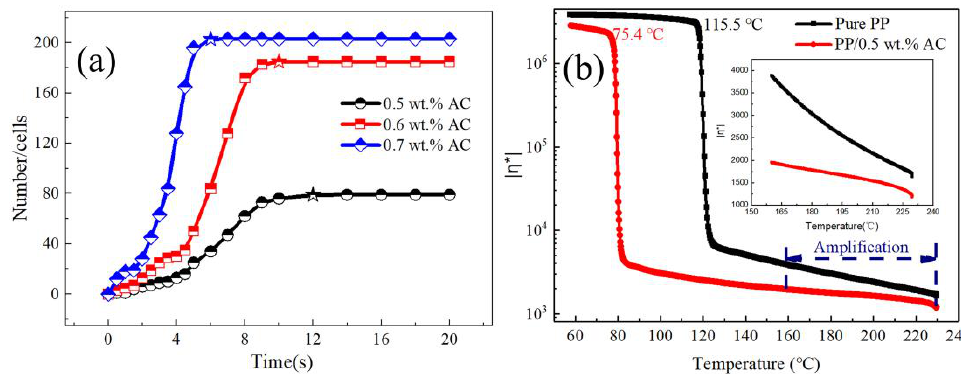
Figure 8. ( a ) Comparison of n - t curves with different foaming agent contents; ( b ) Curves of viscosity of pure PP and PP/AC with changing temperature.